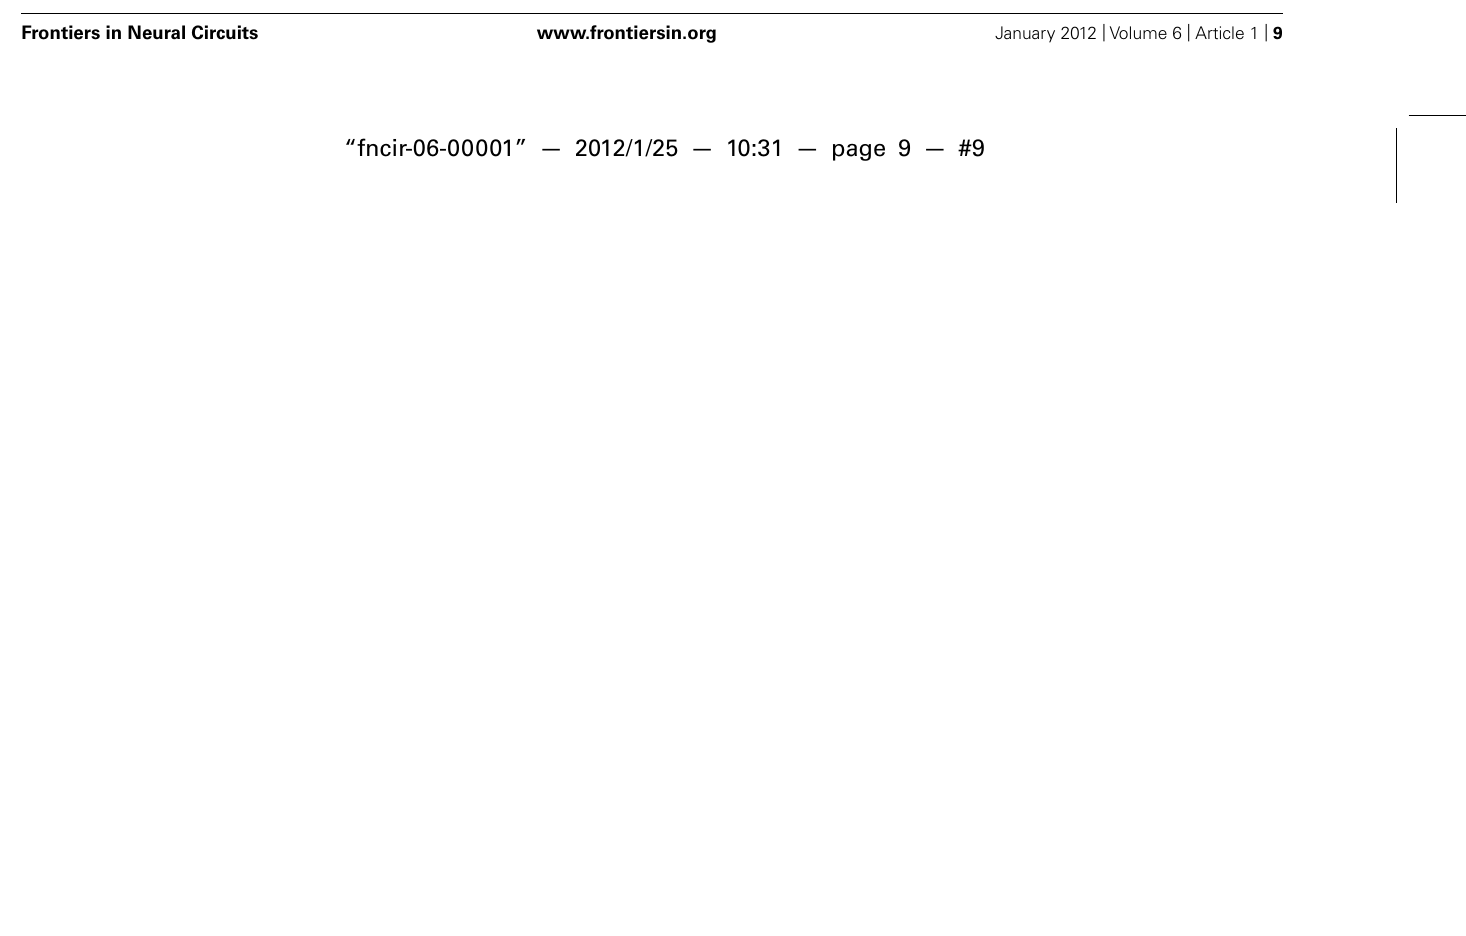
Impairment of glutamate uptake at the level of the granule (GR)–mitral (M) reciprocal synapse (lower box) could lead to an increase of glutamate spillover, provoking the frequency decrease, and power depression of oscillatory activities within the OB circuit in GLAST − / −